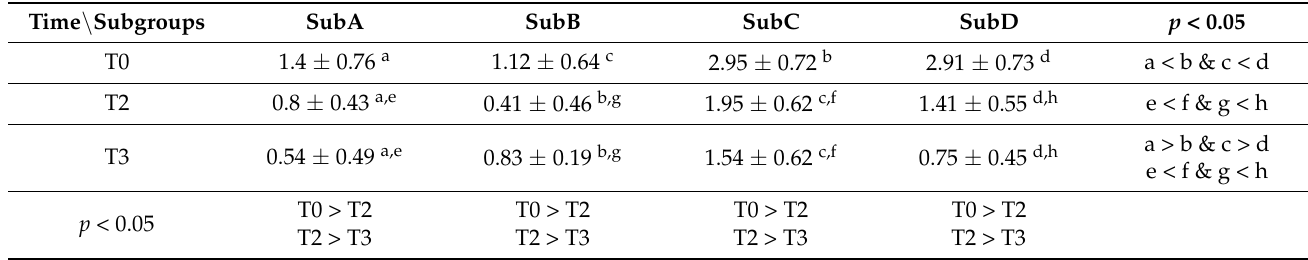
Table 4. Mean and standard deviations for each score of gum status for the (MGI) at the different periods for SubA: Children with no special needs who used a conventional toothbrush; SubB: Children with no special needs who used a customized handle toothbrush; SubC: Children with Down syndrome who used a conventional toothbrush; SubD: Children with Down syndrome who used a customized handle toothbrush. Upper letters ( a–h ) indicate statistically significant differences (raw) between the different subgroups ( p < 0.05).